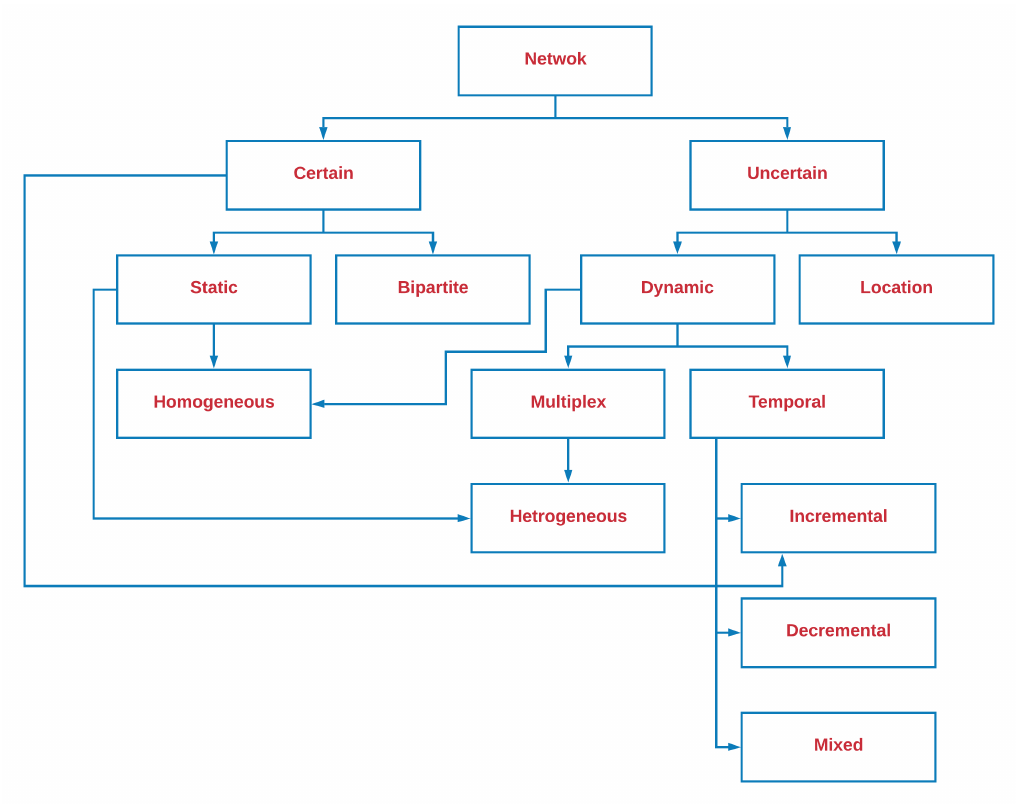
Figure 4. Taxonomy of Networks Used in Link Prediction